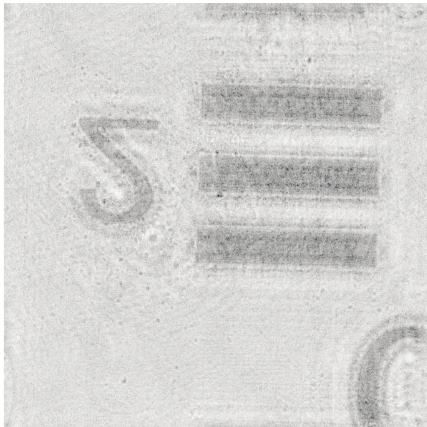
Figure 6: Reconstruction of digital hologram.